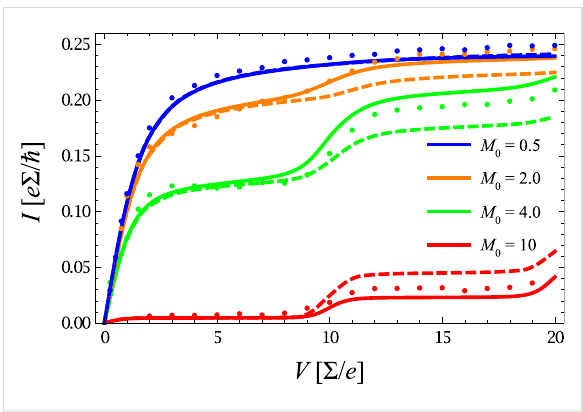
Of course, for ∑ → 0 the standard Fermi distribution is regained. The corresponding steady state phonon distribution eventually provides the current according to Equation 16 with the same replacement (Equation 22) in this expression. The procedure relies on weak electron–phonon coupling m 0 < 1 and in principle also requires sufficiently elevated temperatures.